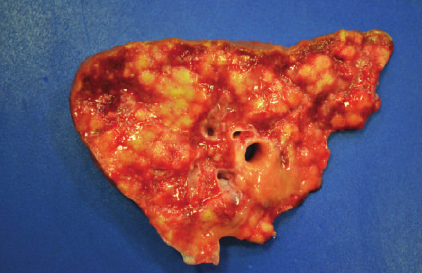
Figure3:Lung.Thepulmonaryparenchymaiseffacedbymultifocal to coalescing, pale, firm nodules similar in appearance to those observed in the parietal pleura, thyroid, liver, bronchial lymph nodes, and internal intercostal muscles.